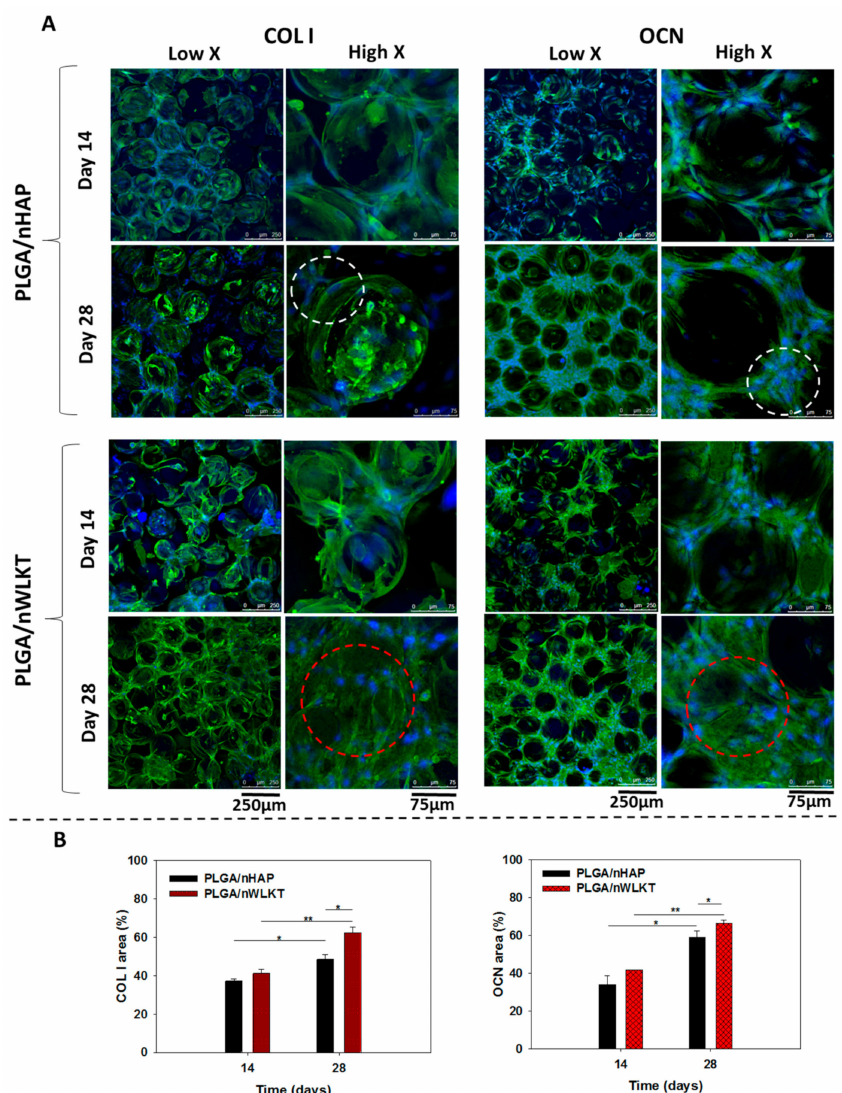
Figure 7. ( A ) Expression of collagen I (COL I) and osteocalcin (OCN) protein by BMSCs when cultured in PLGA / nHAP and PLGA / nWLKT sca ff olds on day 14 and 28 by immunofluorescence (IF) staining. The cell nucleus labeled with Hoechst 33,342 is in blue while proteins labeled with FITC-conjugated antibody are in green (bar: low X = 250 µ m, high X = 75 µ m). ( B ) The semi-quantitative analysis of protein expression developed by an image analysis software (* p < 0.05, ** p <